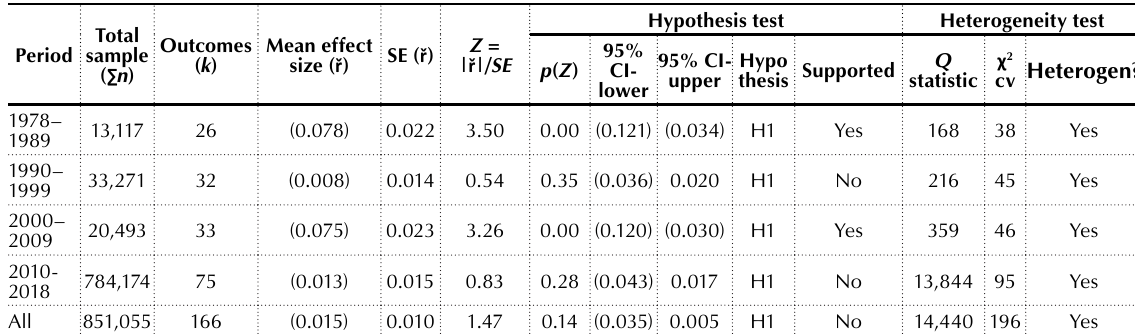
Table 5. Hypothesis testing – meta-analysis – audit